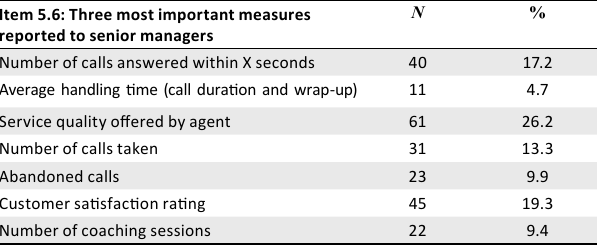
TABLE 10: Measures reported to senior